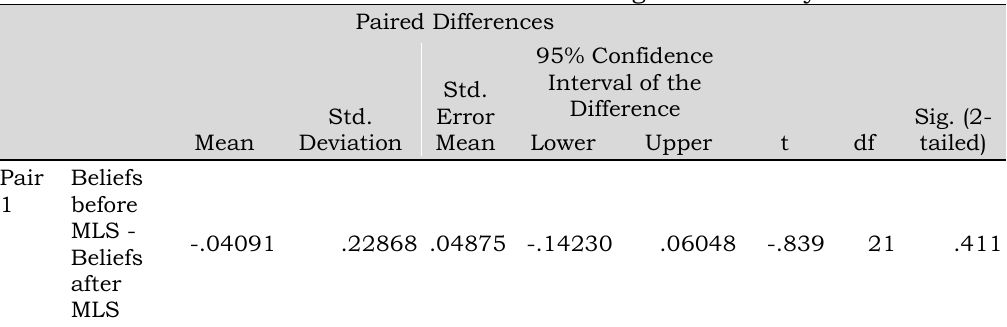
before and after Microteaching Lesson Study Paired Differences 95% Confidence Interval of the Std. Difference Std. Error Deviation Mean Lower